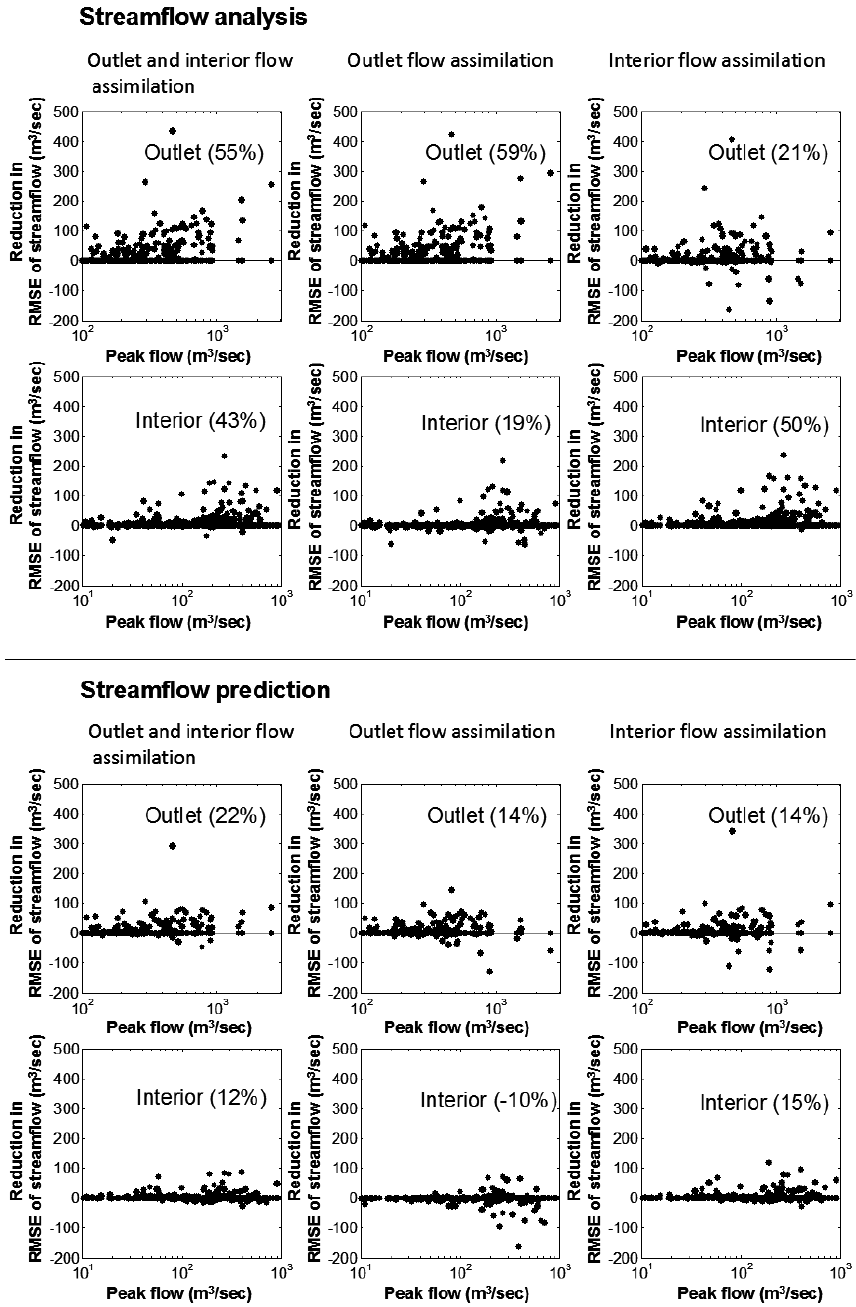
Fig. 11. Reduction in the RMSE of streamflow analysis due to the assimilation vs. peak flows of selected events summarised in Table 2 (top panel); the bottom panel shows the same but for streamflow prediction for 1- to 6-h lead time. The RMSE is calculated for each event and individual lead hour separately. The figure in the parenthesis denotes the percentage reduction in RMSE after the assimilation.